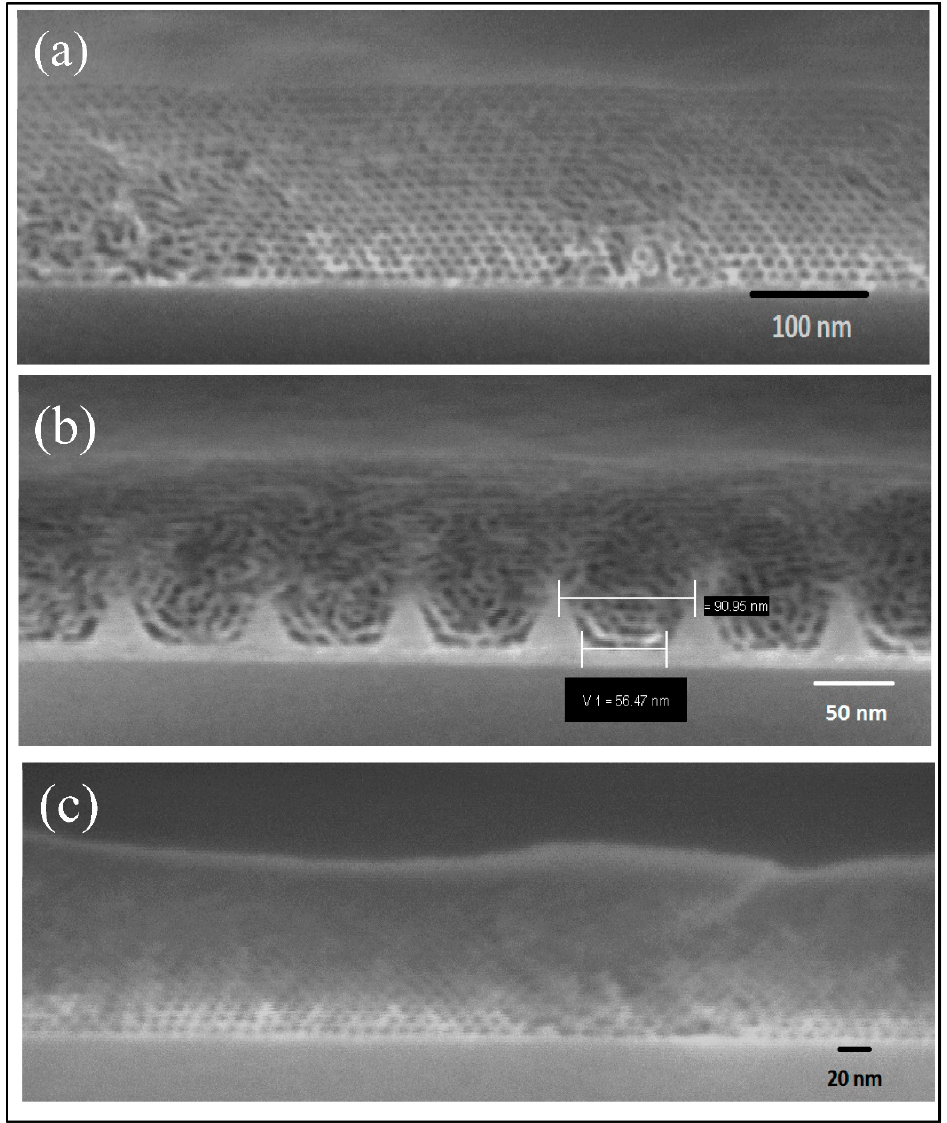
Figure 3. Cross-sectional SEM images of mesoporous silica thin films synthesized using ( a , b ) P-123 on Si and graphoepitaxial defined substrate respectively. ( c ) P-85. on Si and graphoepitaxial defined substrate respectively. ( c )